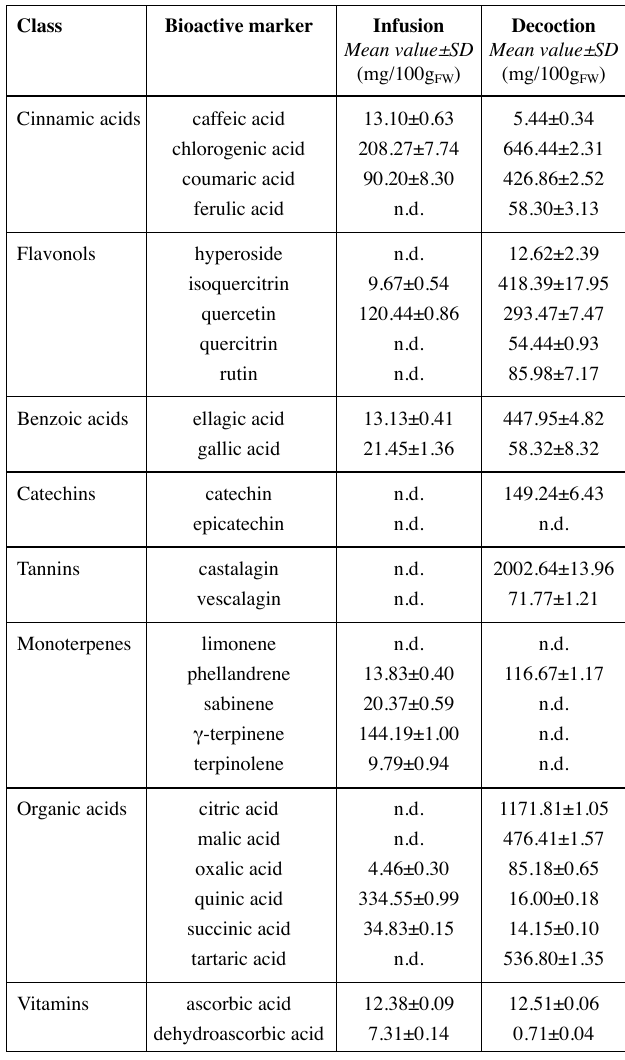
Tab. 4: Phytochemical fingerprint of analyzed samples